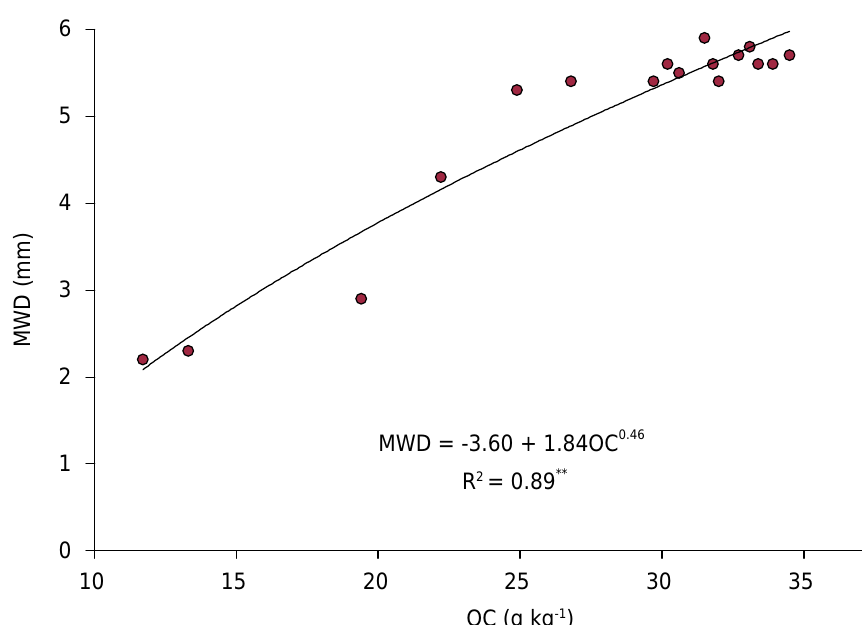
Figure 1. Relationship between the mean weighted diameter (MWD) of aggregates and soil organic C (OC) in the 0.0-0.025 m soil depth, at the beginning and at the end of experiment I and II. **: